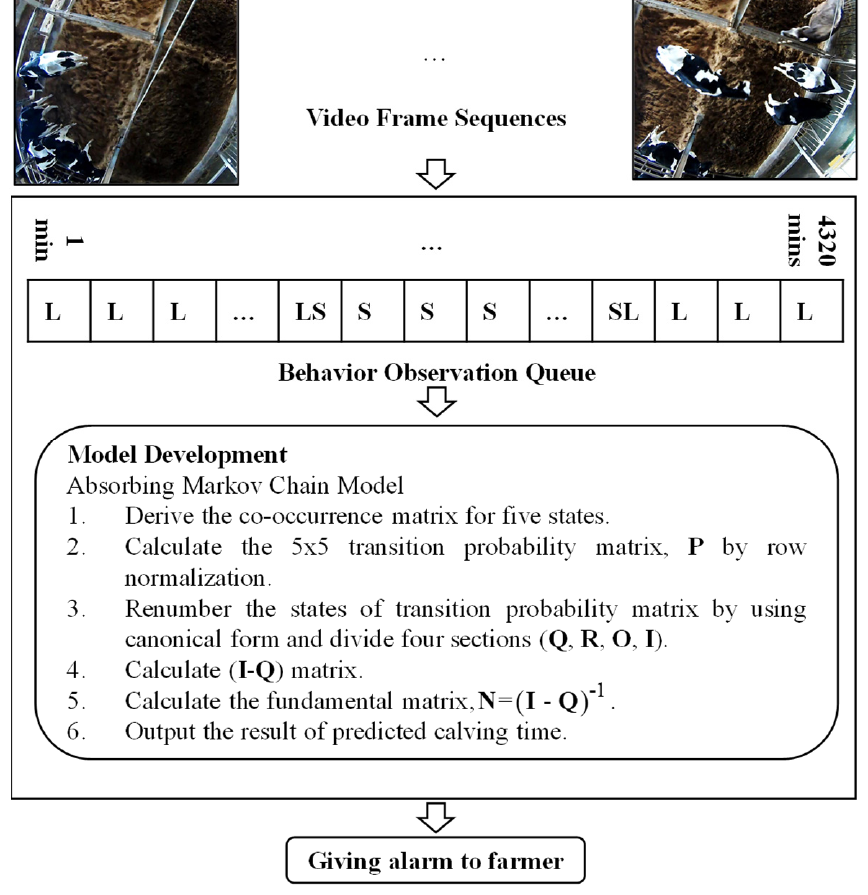
Figure 3. The system architecture of our proposed method.